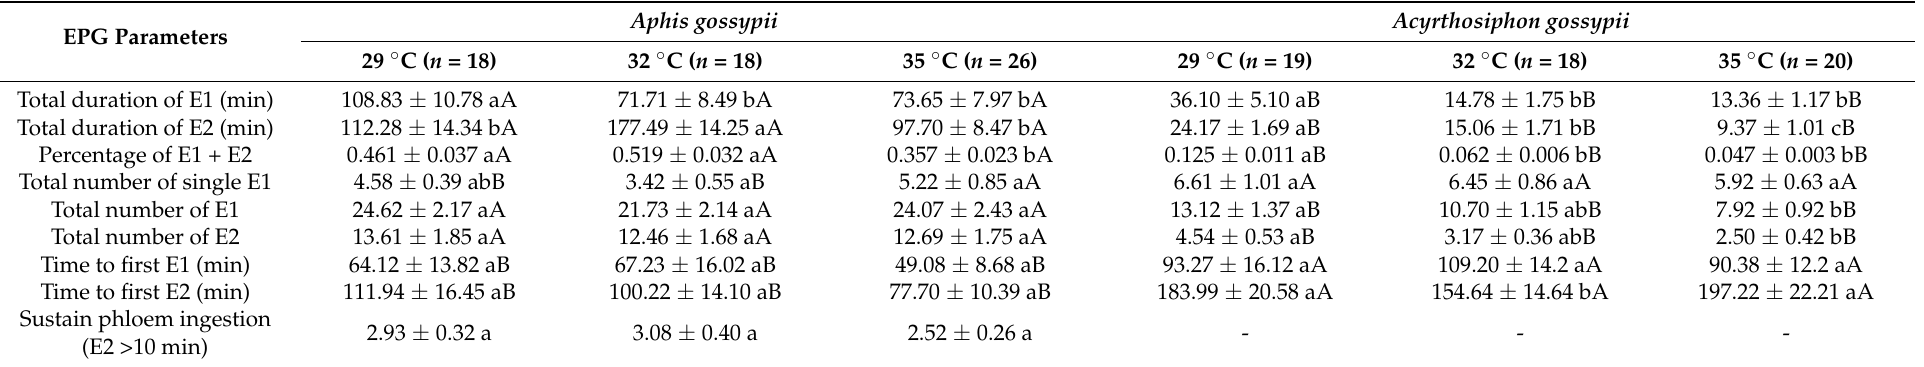
Table 2. Comparison of EPG parameters of Aphis gossypii and Acyrthosiphon gossypii in the phloem phase under different